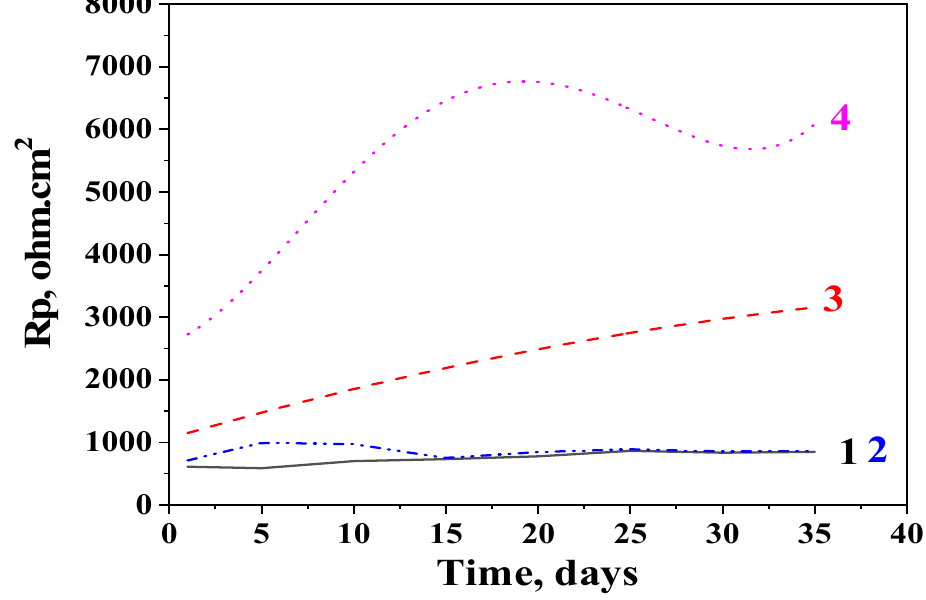
Figure 6. Polarization resistance of ordinary zinc coating in ( 1 ) NaCl and ( 2 ) ASW and of hybrid zinc coating in ( 3 ) NaCl and ( 4 ) ASW.